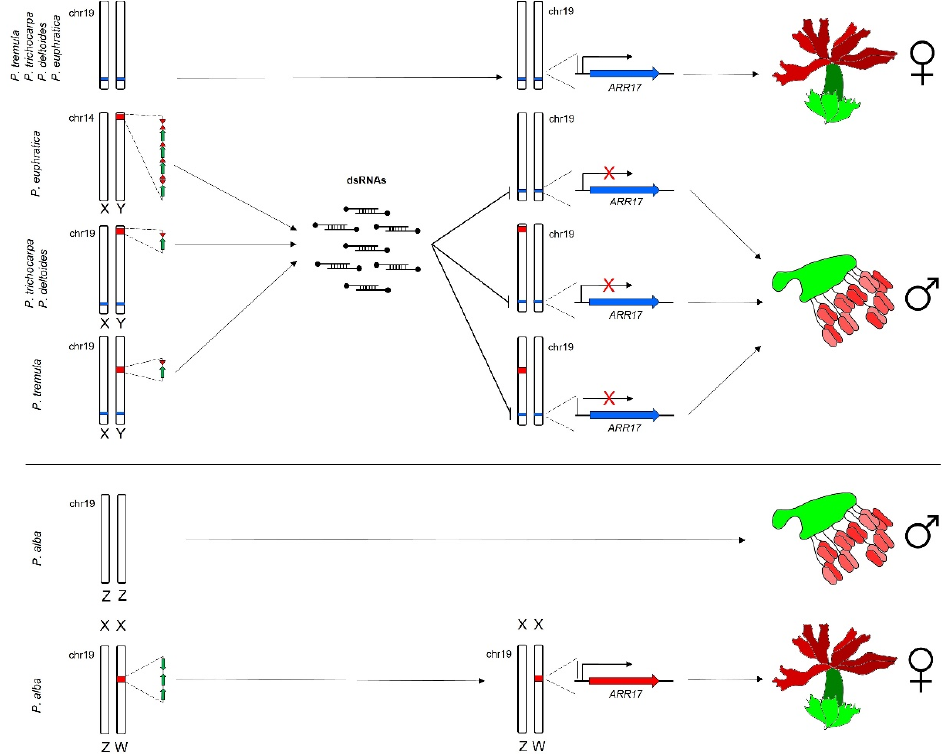
Figure 3. Schematic model of evolution of sex determination in Populus genus. In P. euphratica , P. trichocarpa , P. deltoides and P. tremula , partial inverted duplicates of the ARR17 gene on the Y SDR haplotype act as suppressors of female development by an siRNA ‐ mediated silencing of the intact ARR17 gene located on a different region of chr19. In P. alba , several intact ARR genes totally absent on the Z chromosome act as a dominant promoter of female function. Adapted from ref. [45].